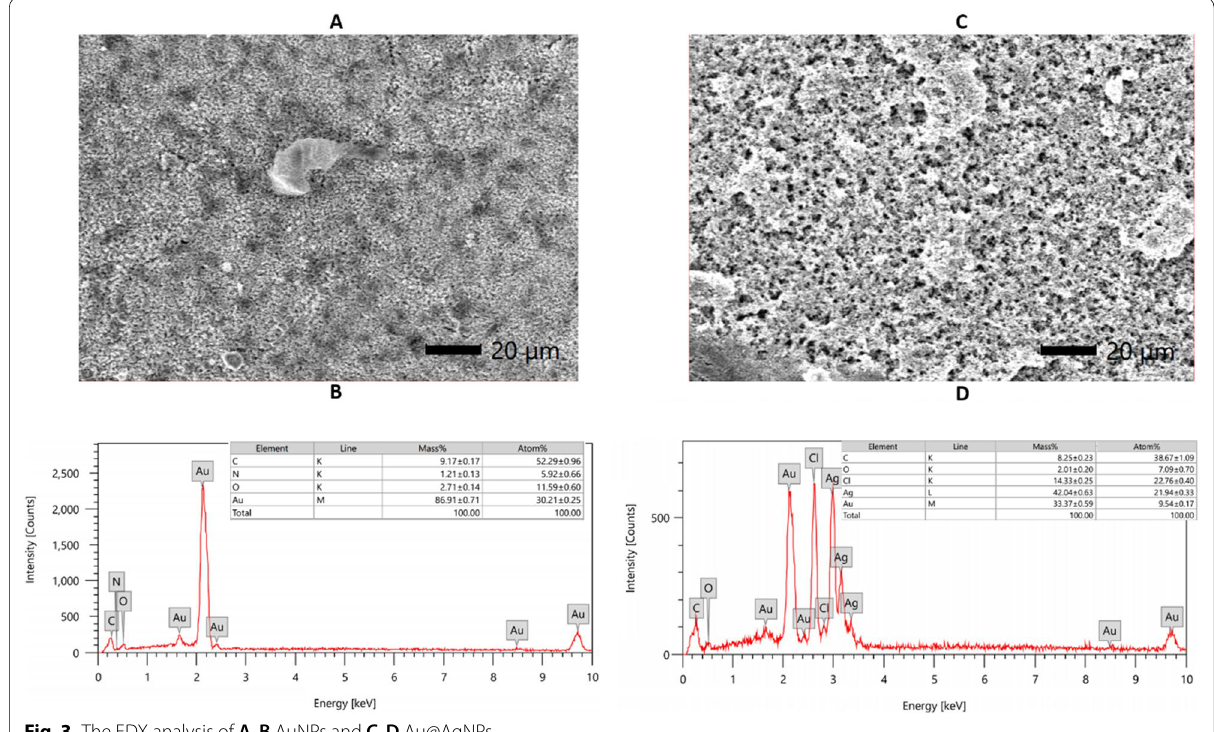
Fig. 3 The EDX analysis of A , B AuNPs and C , D Au@AgNPs